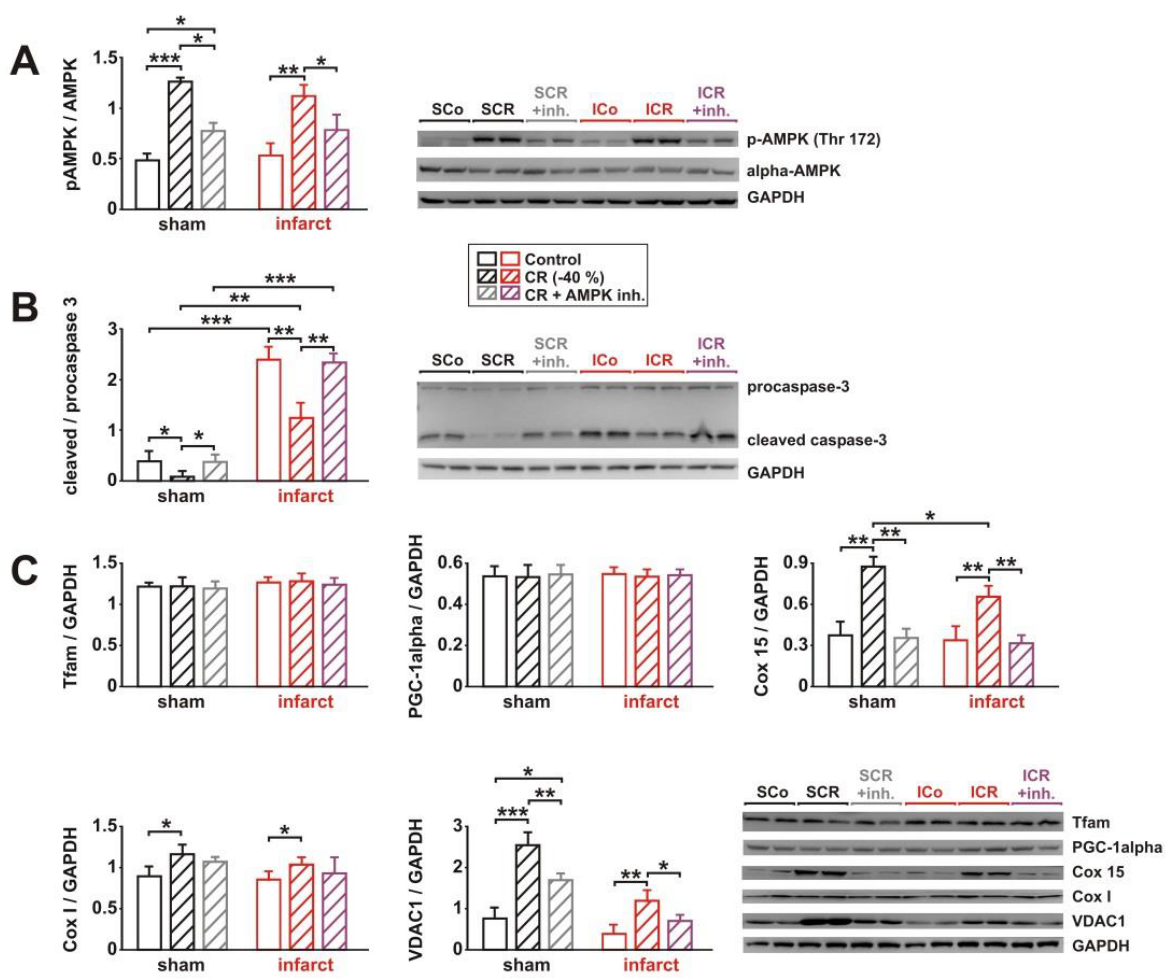
Figure 5. Effect of 8 weeks CR and 2 weeks of AMPK inhibition on AMPK activation, apoptosis, and mitochondrial biogenesis. ( A ): Representative Western blots and quantification of phosphor- ylation of AMPK (at Thr172), normalized to alpha AMPK, in the LV of sham or infarct rats, fol- lowing 8 weeks of control or CR diets and AMPK inhibition. ( B ): Representative Western blots and quantification of full-length and large fragment (17/19 kDa) of cleaved, activated caspase-3 in the LV of sham or infarct rats, following 8 weeks of control or CR diets and AMPK inhibition. GAPDH served as loading control. ( C ): Representative Western blots and quantification of protein expres- sion of Tfam, PGC-1alpha, mitochondrial components of complex IV (Cox 15 and I), and VDAC1, normalized to GAPDH, in LV tissue. All data are mean ± SEM. n = 6–7 animals per group, *: p < 0.05; **: p < 0.01; ***: p < 0.001. Full size blots are provided in Supplementary Figure S5.